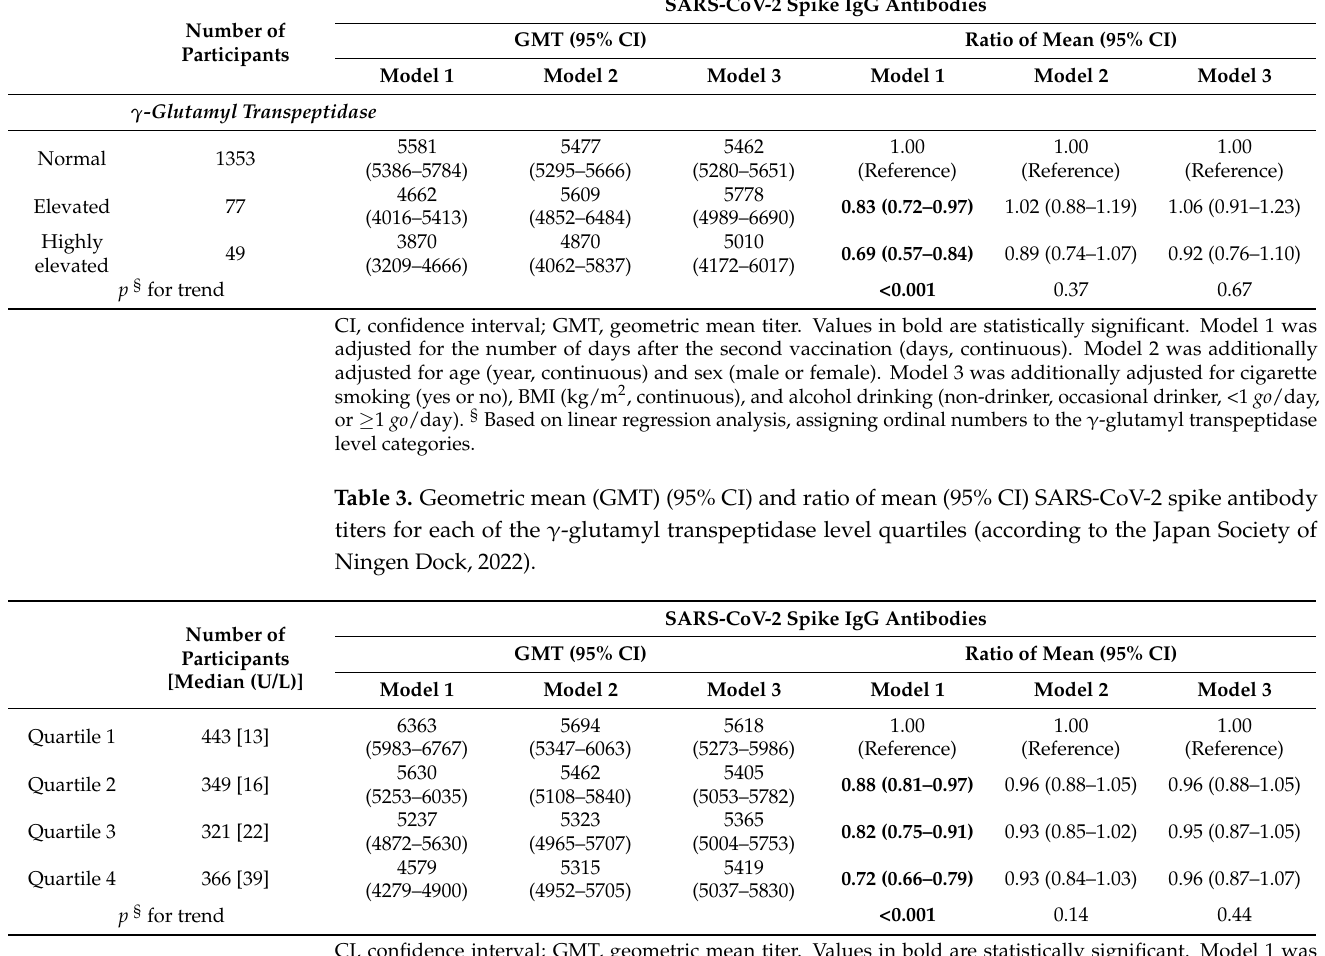
Table 2. Geometric mean (GMT) (95% CI) and ratio of mean (95% CI) SARS-CoV-2 spike antibody titers for each of the categories of γ -glutamyl transpeptidase level (according to the Japan Society of Ningen Dock, 2022).